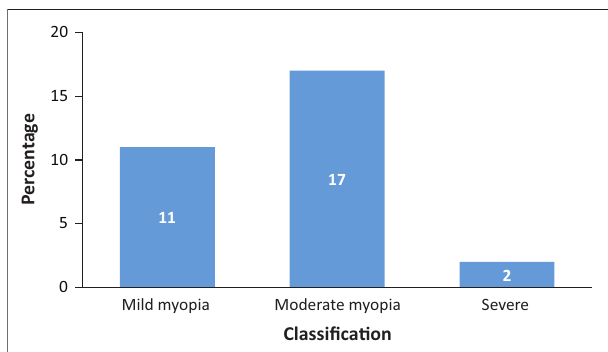
FIGURE 2: Magnitude of myopia in the study